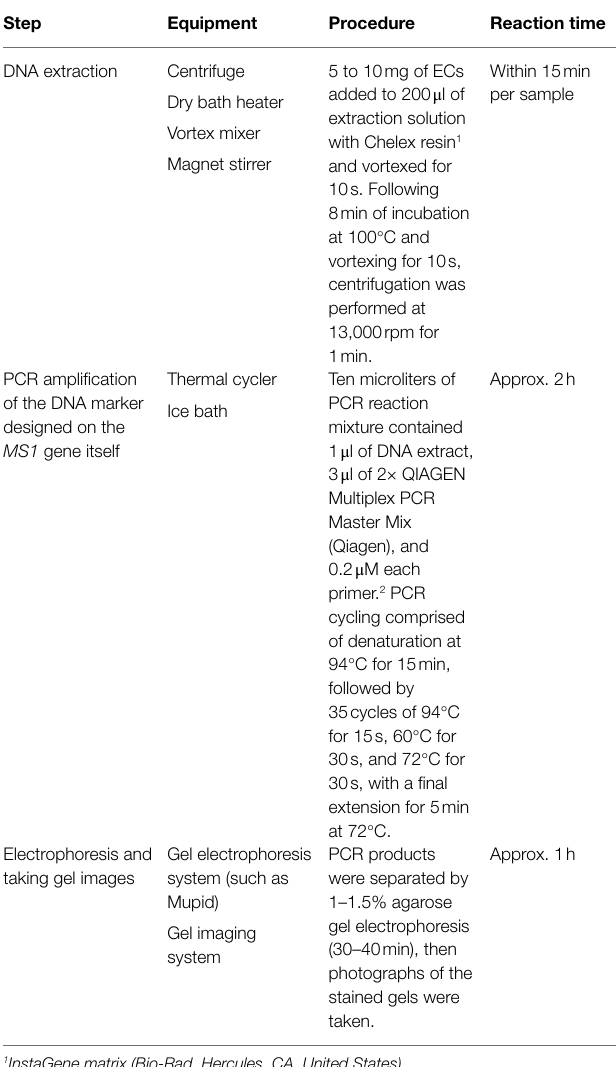
TABLE 3 | Procedures and reaction conditions for a simplified method for the discrimination of pollen-free sugi ( C. japonica ) embryogenic cell